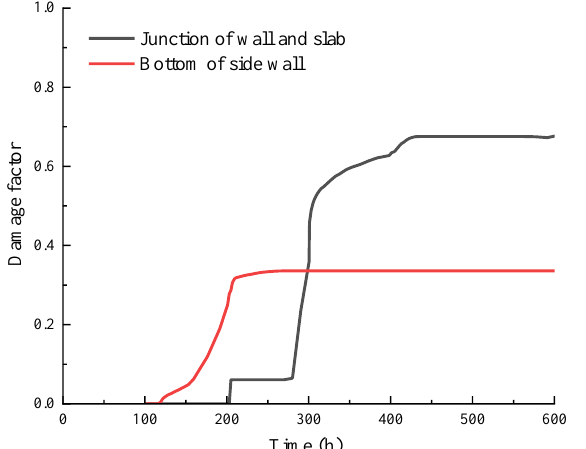
Figure 8. Damage distribution of side wall after pouring.